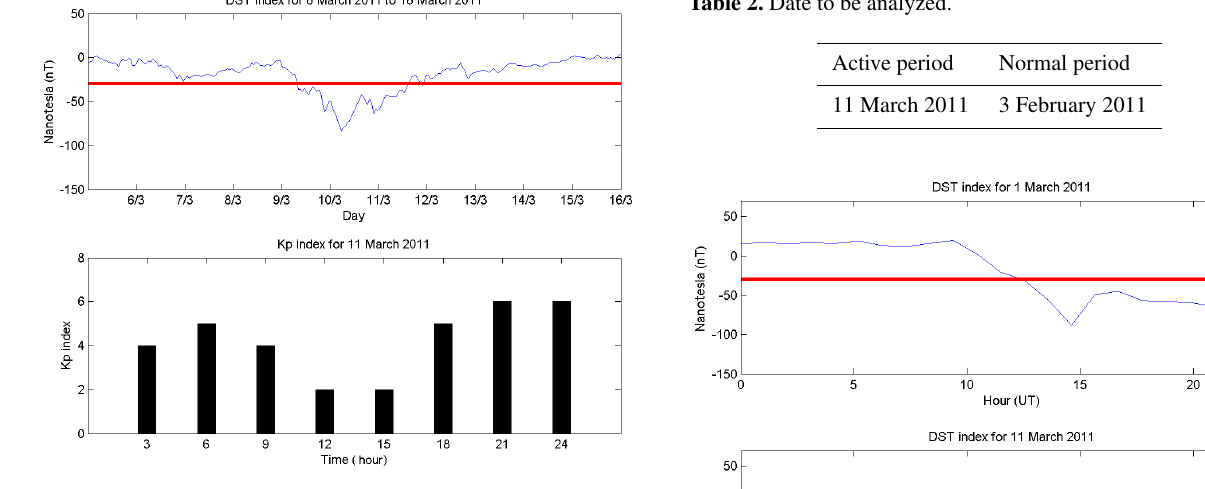
Figure 2. The D st index for 6 to 16 March 2011 and the K p index for the active period on 11 March 2011.